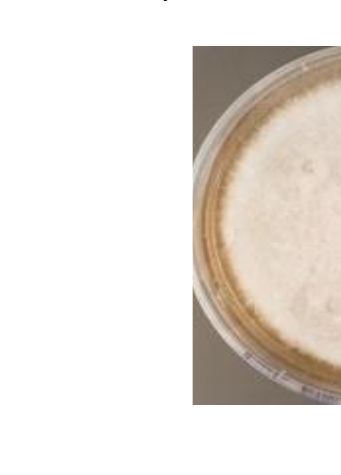
Figure 9. Reduction in the density of F. oxysporum mycelium in the presence of EO 2 ( a ), compared to control sample ( b ).